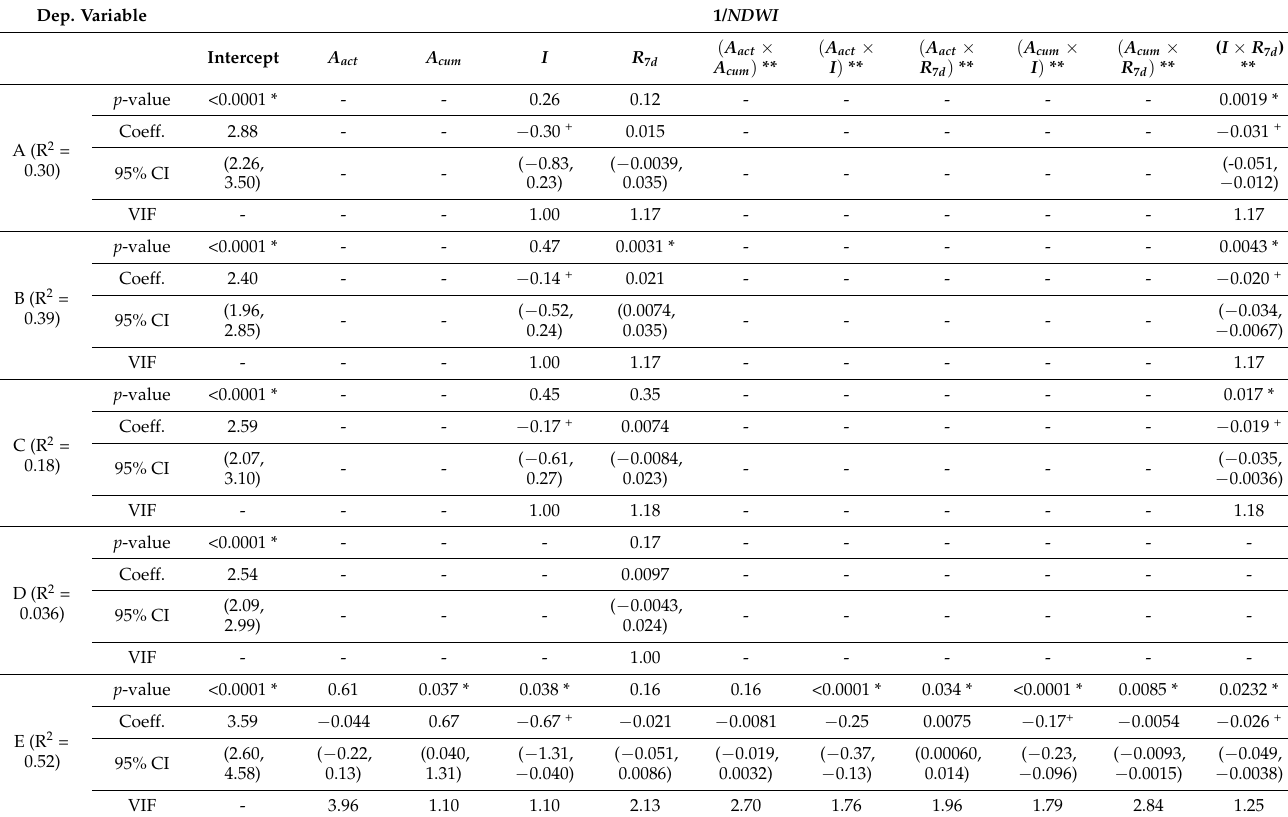
Table 10. Statistical models to predict mean NDWI in the five monitoring